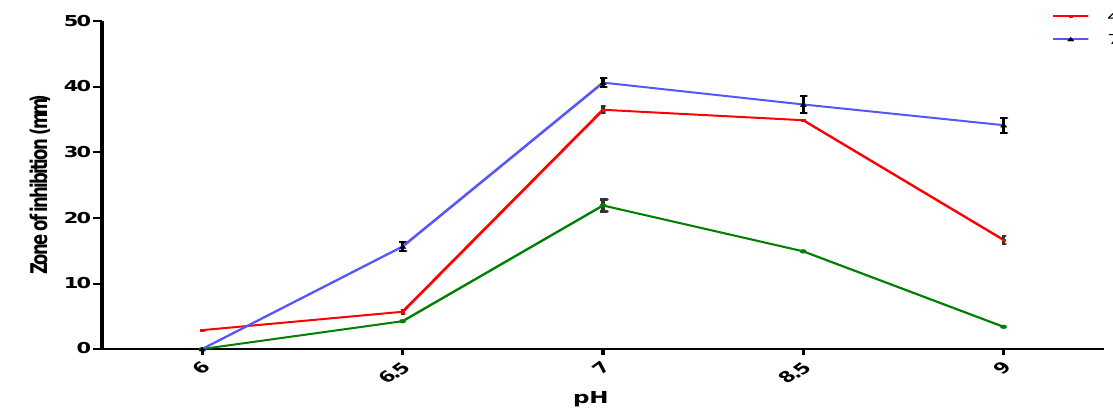
Figure 6. Effect of pH on the haemolytic activity of Proteus